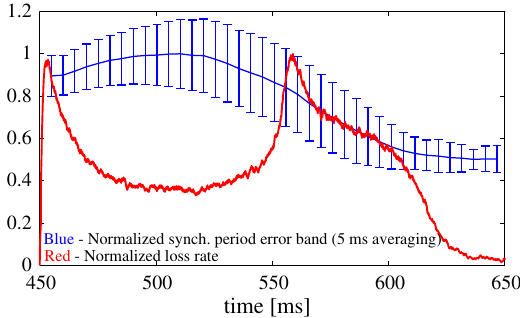
FIG. 13. Half-integer (long bunch simulations). The loss rate (red) vs the synchrotron period of the lost particles (blue). One can observe the different regimes before and after 558 ms, where the bunch shortening starts to interest prevalently the particles inside the inner separatrix (with smaller synchrotron period).